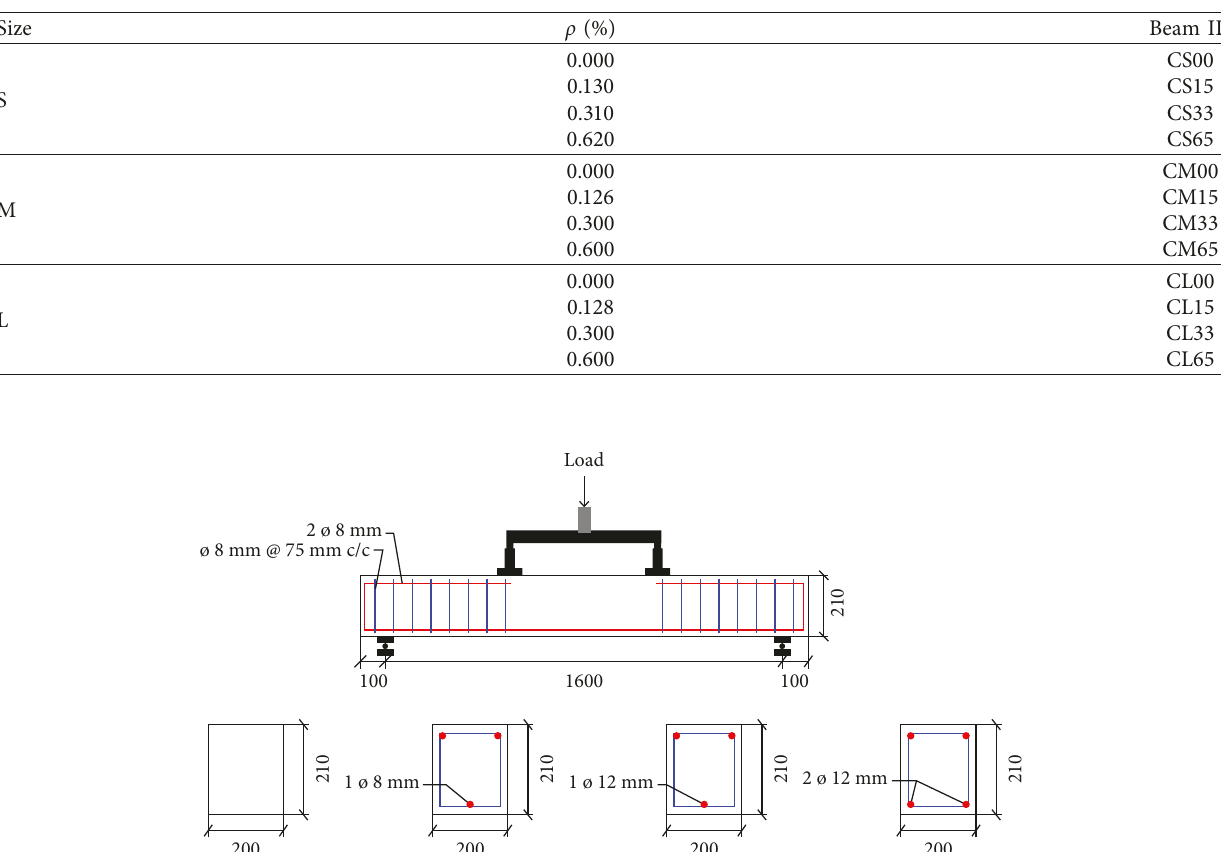
Table 7: Details of the beam specimens.